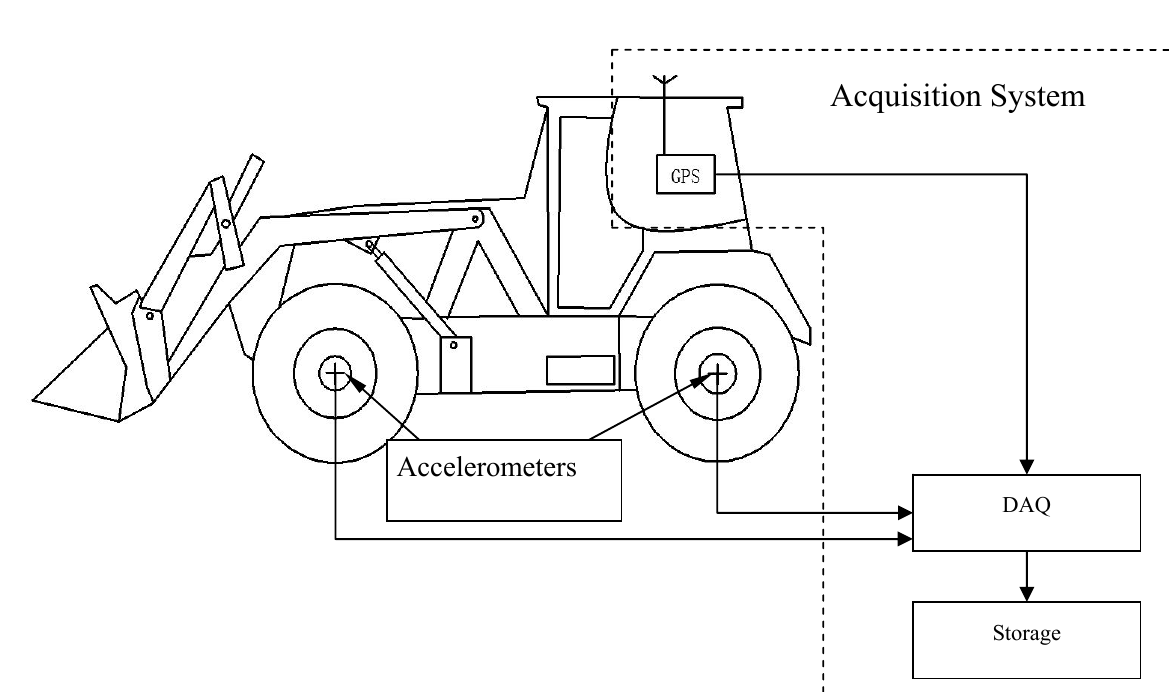
Figure 1. Vehicle response acquisition